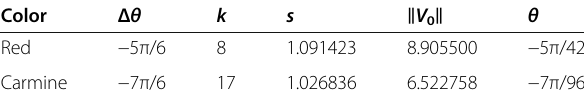
Table 5 The specific data of typical curve by exchanging the two endpoint-orientation